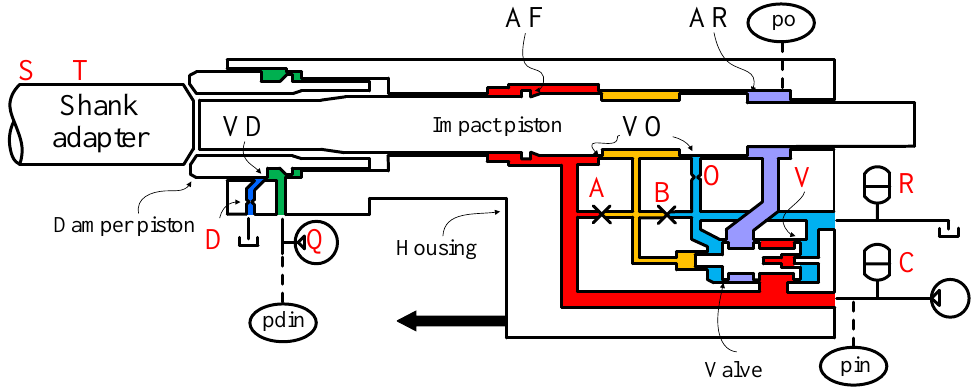
Figure 1. Schematic diagram of the hydraulic rock drill, where red capital letters indicate different induced fault modes and approximate locations, and ovals indicate the positions of sensors